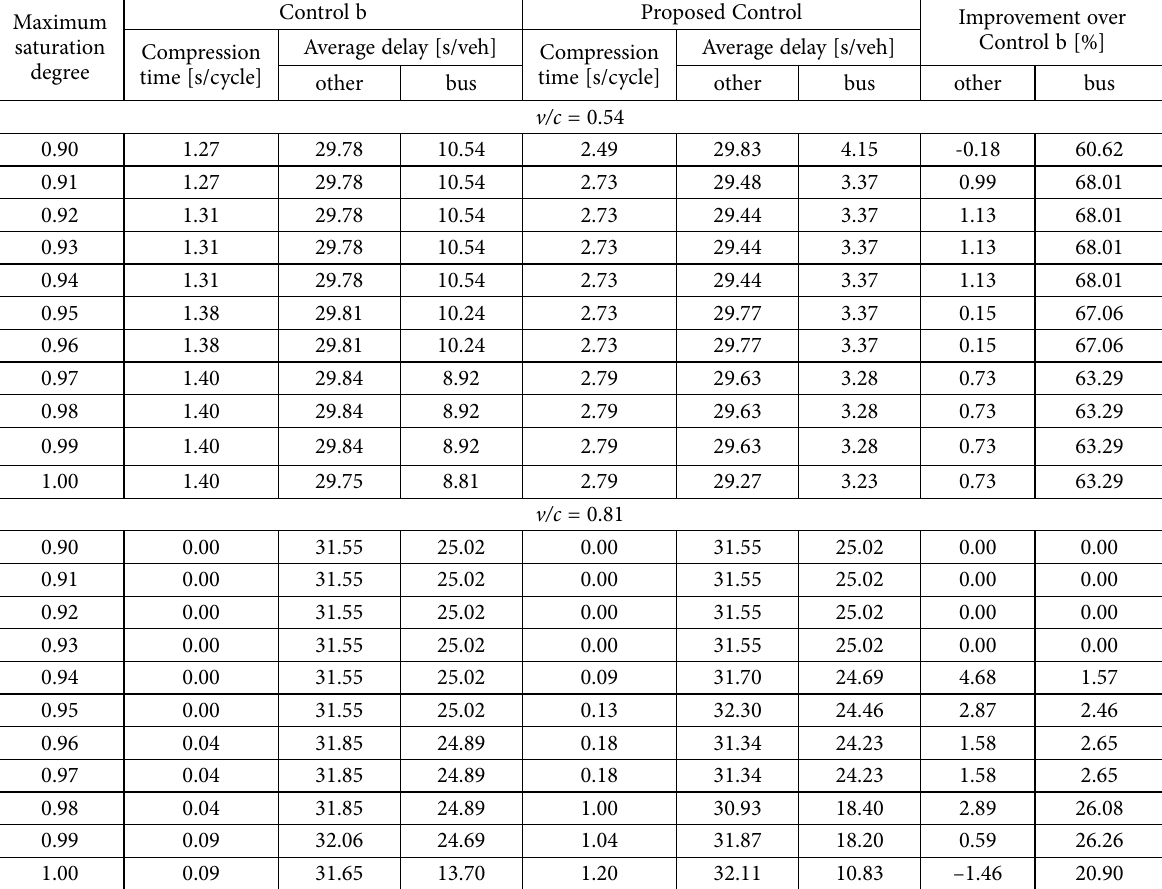
Table 6. Impact of maximum saturation degree on control performance Maximum